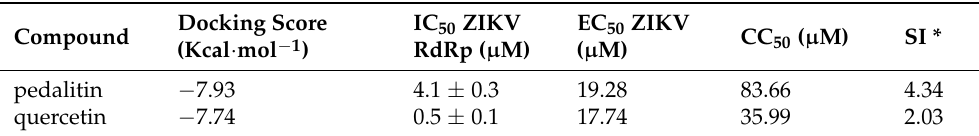
Table 2. Summary of the computational and experimental results for the best two compounds found in this study.